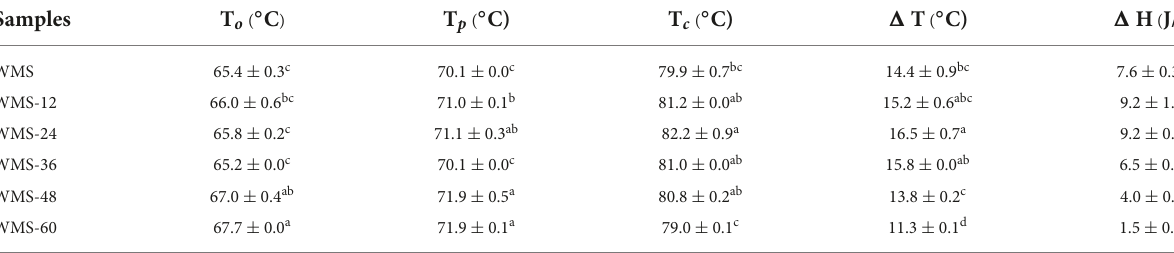
TABLE 3 The thermal properties of native and fermented